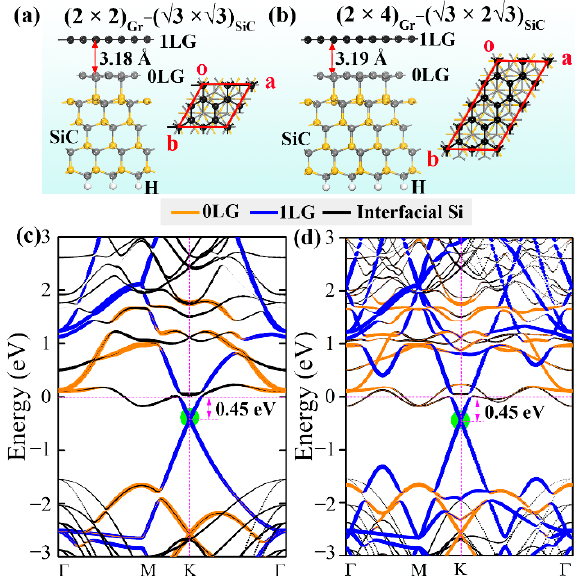
Figure 6. ( a , b ) (2 × 2) Gr − ( √ 3 × √ 3) SiC and (2 × 4) Gr − ( √ 3 × 2 √ 3) SiC graphene − SiC interface atomic configurations, respectively. Black, gray, and yellow balls represent C atoms in graphene, C atoms in SiC, and Si atoms, respectively. ( c , d ) The corresponding electronic band structures. The orange, blue, and black lines represent the contribution of 0LG, 1LG, and interfacial Si of SiC substrate, respectively. The green circles show the location of the graphene Dirac point.